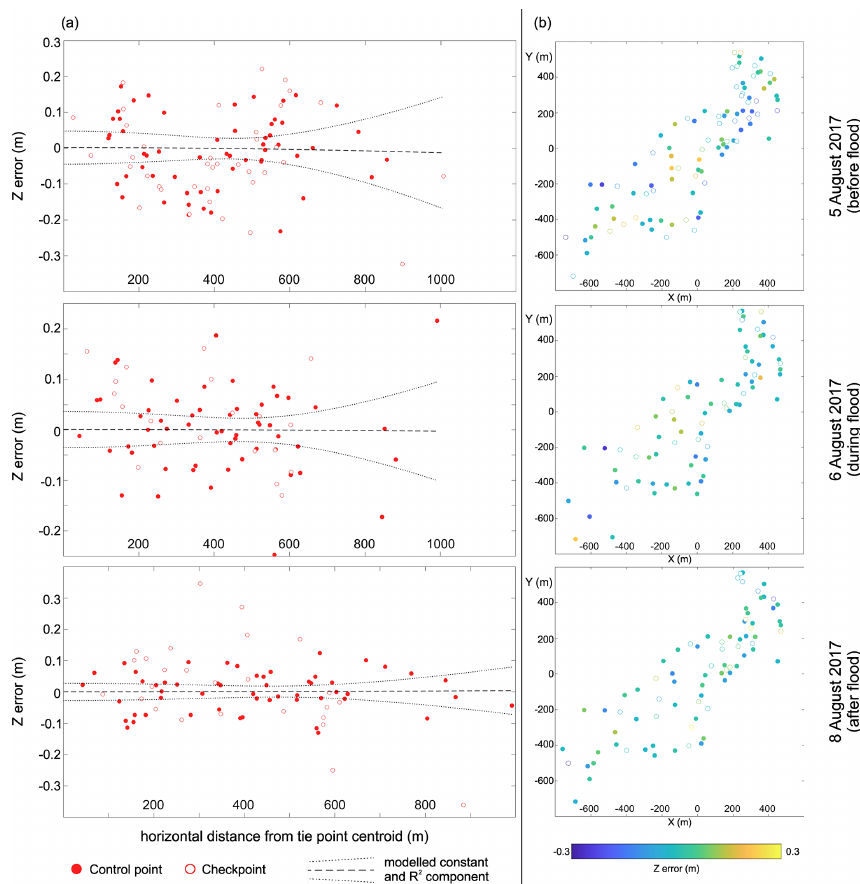
Figure 5. Spatial distribution of errors on control points and checkpoints: (a) Z error against radial distance from the tie point cloud centroid (i.e. from the centre of the reconstructed scene). The distribution of errors along a straight line (indicated here also as “modelled constant”) suggests that no systematic errors such as doming or dishing were observed in the reconstructed scenes (see James et al., 2020, for details about interpretation); (b) Z error by colour in plan view ( X and Y are distanced from tie point centroid). Note that each row shows an individual